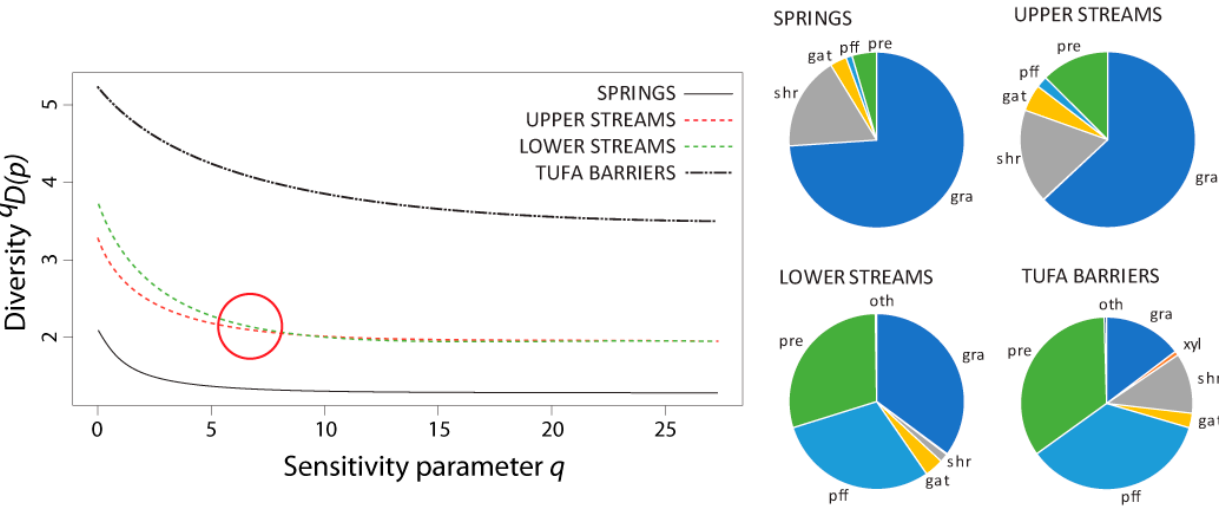
Figure 5. Diversity profiles of caddisfly communities from four different freshwater karst habitat types using a similarity matrix based on functional feeding groups (FFGs). The ratios of specific FFGs in different habitat types are displayed next to the profile. The red circle denotes the intersection between the curves for the upper and lower streams. Abbreviations for feeding types: grazers and scrapers = gra; xylophagous taxa = xyl; shredders = shr; gatherers/collectors = gat; passive filter feeders = pff; predators = pre; other feeding types = oth. (Lower streams: xyl were present with proportion less than 0.2%—not shown